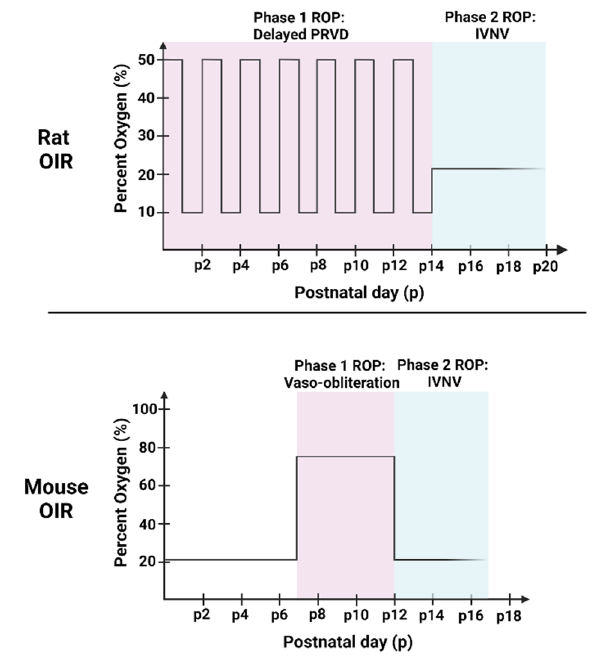
Figure 1. Diagram of the two phases in the rat and mouse OIR models. Phase 1 ROP in the rat OIR is characterized by delayed physiologic retinal vascular development (PRVD) and compromised physiologic vascularity, followed by hypoxia-induced intravitreal neovascularization (IVNV) in Phase 2. Phase 1 in the mouse OIR is characterized by vaso-obliteration followed by hypoxia-induced IVNV in Phase 2. Created with